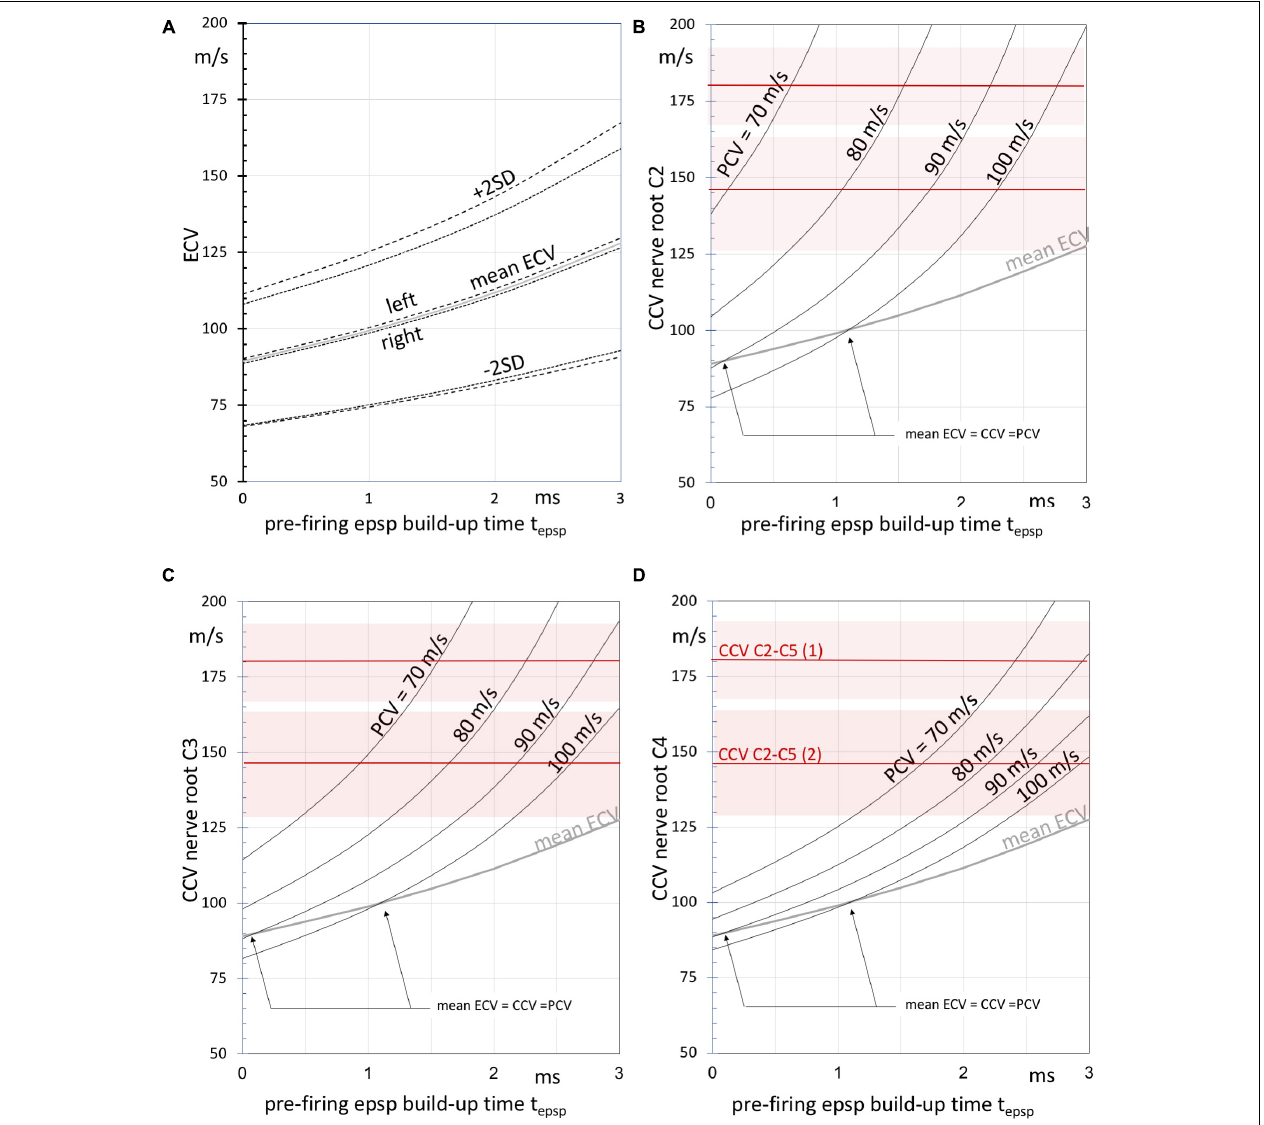
FIGURE 6 | (A) Graphs of the left, right and estimated overall mean (dashed, dotted and gray lines, respectively) ± SD compound motor conduction velocities ECV after PN + MN + NMJ synaptic delay exclusion according to Table 4 as function of the build-up time t epsp , of epsp’s until firing after the start of TES. The ECV values result from the TES muscle MEP latency times. Panels (B–D) depict curves of the estimated (intradural) central motor conduction velocities (CCV) at three cervical nerve levels C2 (panel B ), C3 (panel C ), and C4 (panel D ) as function of t epsp using the estimated intradural fractions of the direct routes. The curves are given at peripheral motor conduction velocities (PCV) between 70 and 100 m/s. Note that higher CCVs are associated with lower PCVs and vice versa to outbalance the ECV values. The gray curves represent the mean ECV. The arrows indicate intersecting points at which mean ECV values are equal to peripheral and central motor conduction velocities. The horizontal red lines represent mean CCVs as derived from the multifidus MEP latencies enclosing the segmental region between cervical nerves C2 and C5 in two horses, numbered (1) and (2). Shaded areas represent the SEM.